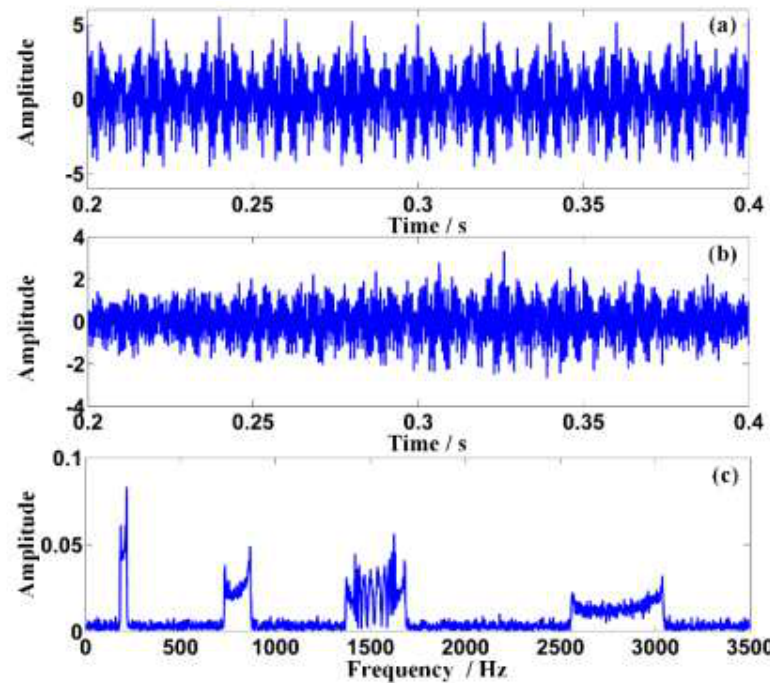
Figure 6. The Doppler effect of the simulated signal: ( a ) the waveform of the origin signal with SNR of 10 dB; ( b ) the waveform of the Doppler distorted signal; ( c ) the frequency spectrum of the Doppler distorted signal.